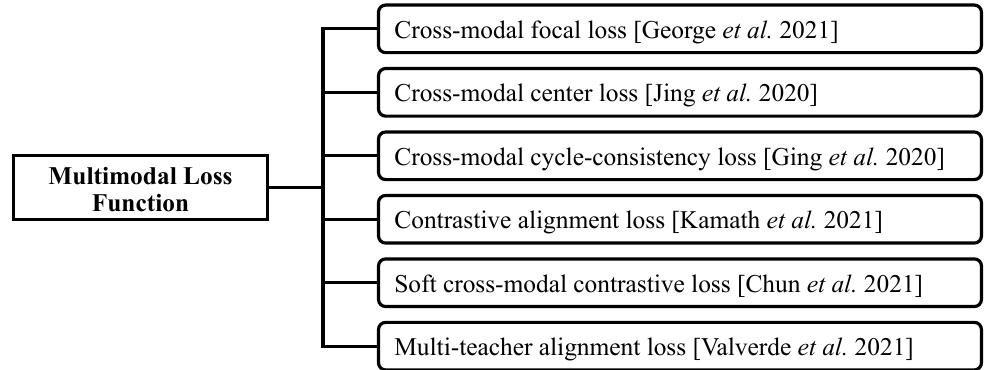
Figure 2. Multimodal loss function